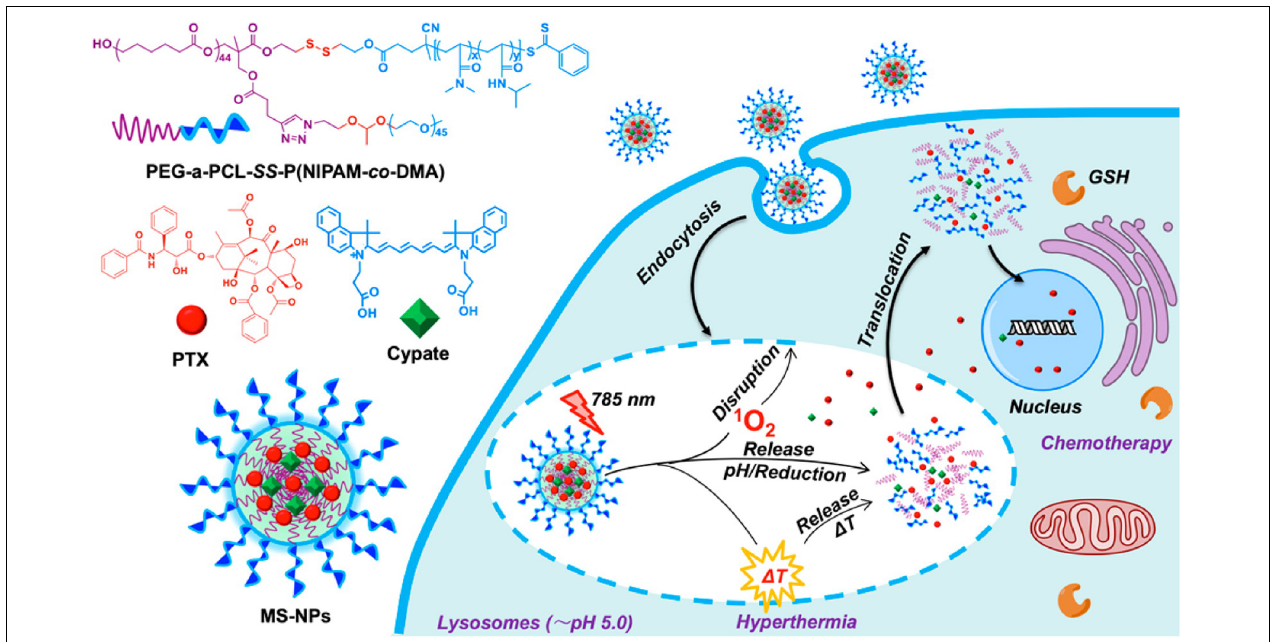
FIGURE 10 | Schematic illustration of NIR light/pH/reduction-responsive nanoparticles. The NIR Light/pH/Reduction–responsive nanoparticles consist of PEG-a-PCL-SSP(NIPAM-co-DMA) (S1) star quaterpolymer for precise cancer therapy synergistic effects. Reprinted from Xiaonan An, Aijun Zhu, Huanhuan Luo, et al. Rational Design of Multi-Stimuli-Responsive Nanoparticles Precise Cancer Therapy. ACS Nano. 2016;10(6):5947–58. With permission from reference (An et al., 2016). NIR, near-infrared; PEG, poly(ethylene glycol); PCL, poly( ε -caprolactone); NIPAM, N-isopropylacrylamide; DMA, dimethylacrylamide; GSH, cytoplasmic glutathione; MS-NPs, multi-stimuliresponsive nanoparticles.